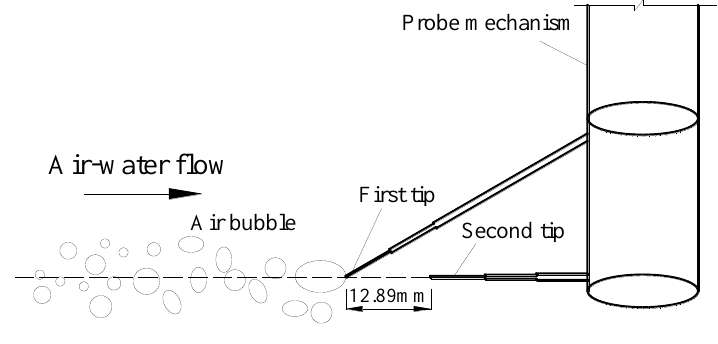
Figure 4. Sketch of the double-tip conductive probe.